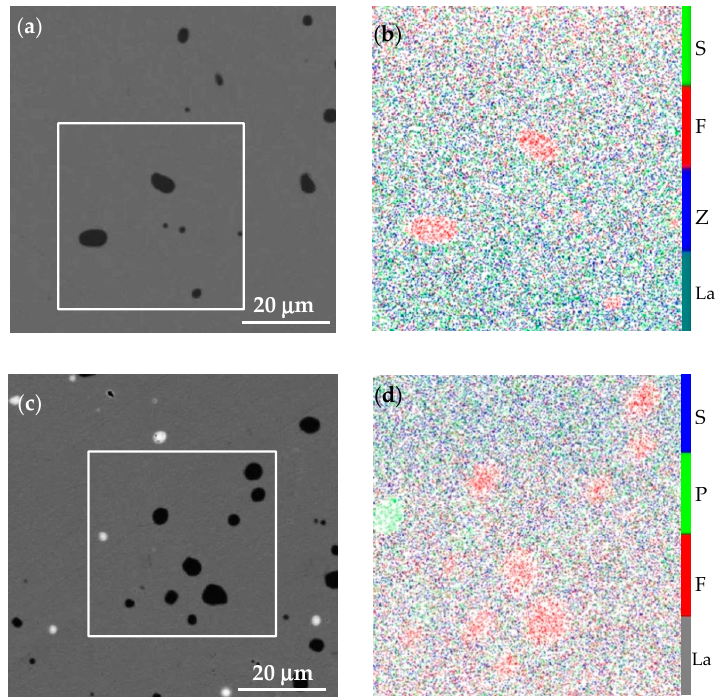
Figure 3. Backscatter SEM images of the annealed LaFe 11.6 Si 1.4 Zn 0.03 ( a ) and LaFe 11.6 Si 1.4 P 0.03 plates ( c ). Images ( b ) and ( d ) are the corresponding elemental distributions within the areas marked by squares in ( a ) and ( c ), respectively.